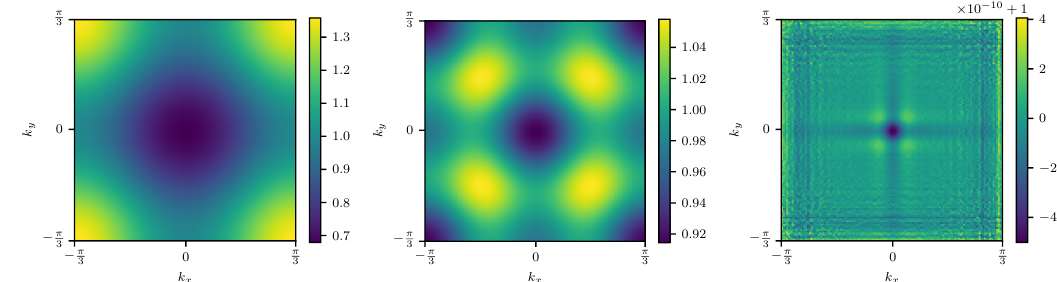
Figure 1: Berry curvature of the 3-band Kapit-Mueller model (left), after one iteration of the flattening algorithm (middle), and after 12 iterations (right). Note the scales of the colorbars. The curvature is scaled such that average curvature of 1 corresponds to a band with Chern number 1. Because of the magnetic translation symmetry by one lattice constant, the Berry curvature pattern repeats three times, and we only show one third of the magnetic Brillouin